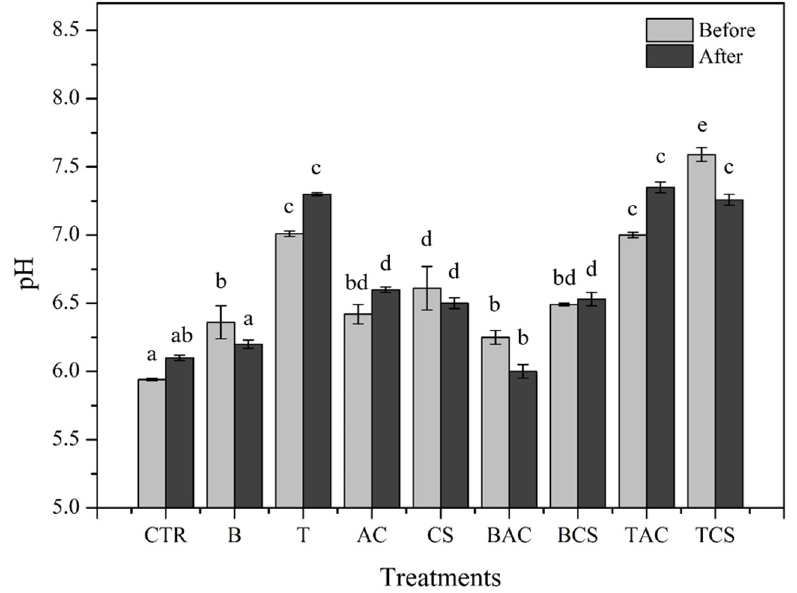
Figure 3. pH of soils at various amendment treatments before and after phytotoxicity test. Means with the same letters are not significantly different from each other under different amendment treatments according to Tukey’s test ( p < 0.05, n = 3) (CTR: control, B: bentonite, T: talc, AC: activated carbon, CS: cornstarch).